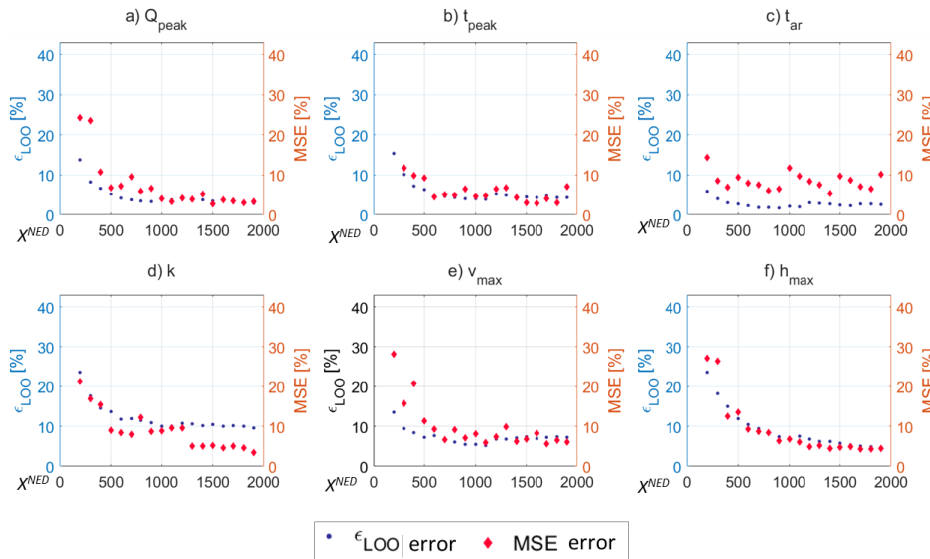
Figure 9. The value of 𝜖 𝐿𝑂𝑂 [%] and mean squared error (MSE) error [%] calculated for each model output using different sizes of ED . a) peak discharge, Q peak ; b) time to the peak discharge, t peak ; c) time to the flood arrival, t ar ; d) recession constant, k ; e) maximum water velocity, v max ; f) maximum water depth, h max , at the last cross section at the end of the channel.